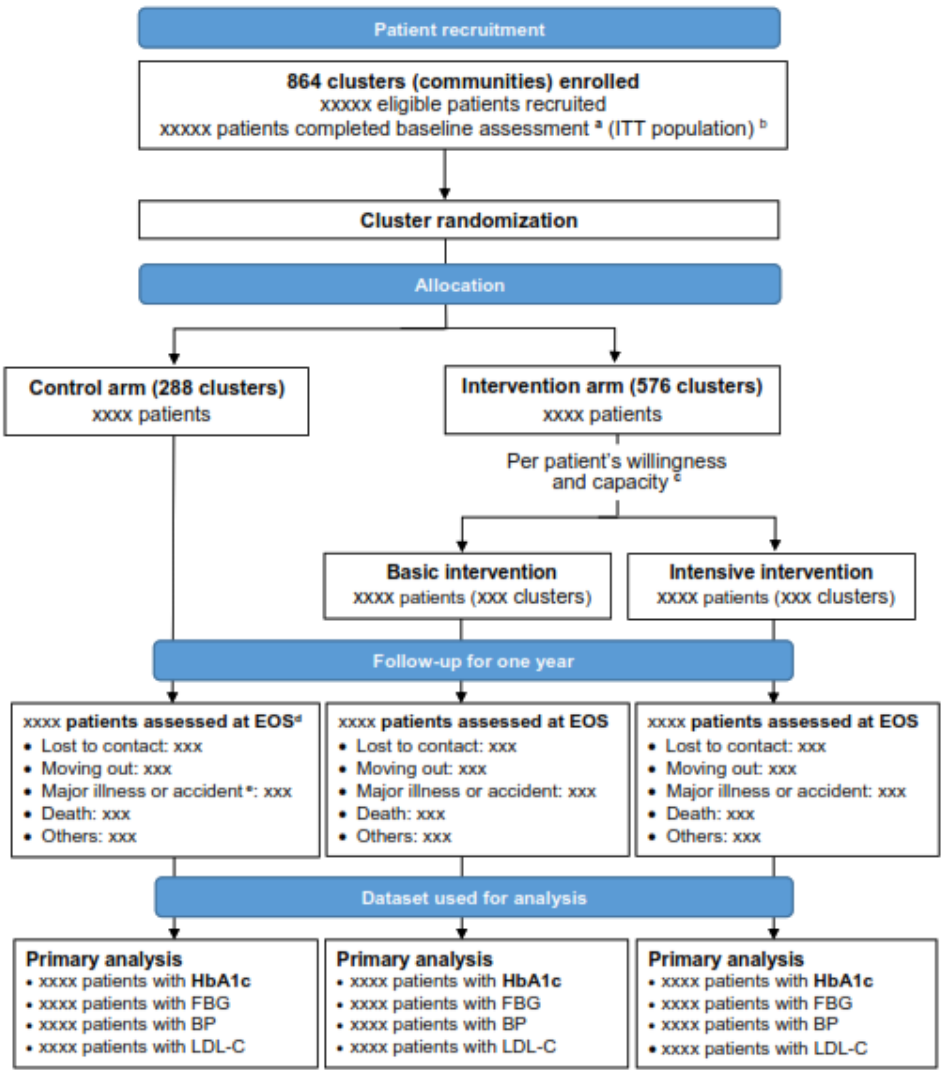
Figure 1. CONSORT diagram for the randomized control trial. BP: blood pressure; EOS: end of study; FBG: fasting blood glucose; HbA 1c : glycated hemoglobin; ITT: intention-to-treat; LDL-C: low-density lipoprotein